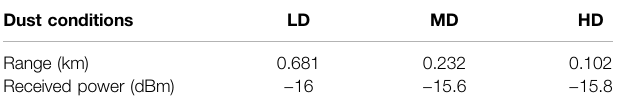
TABLE 10 | Maximum propagation ranges and received power under different dust storm conditions with log (BER) < −